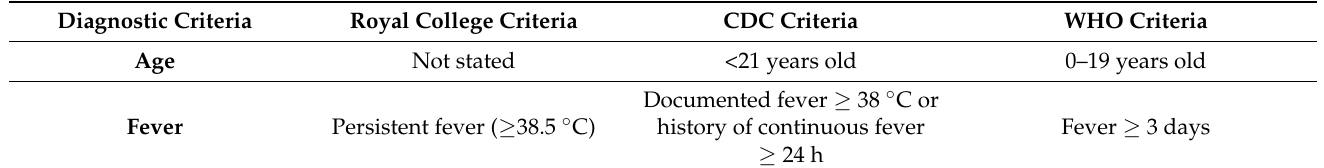
Table 1. Diagnostic criteria in